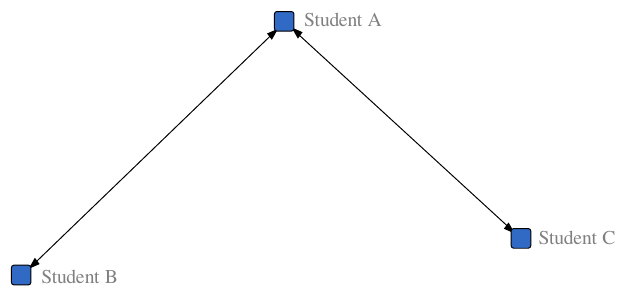
FIG. 1 (color online). Example sociogram of three students collaborating on